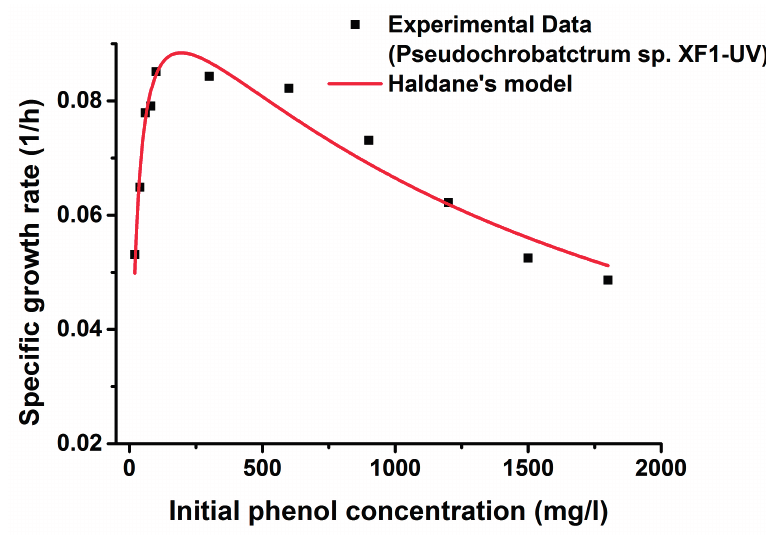
Figure 6. Experimental and predicted specific growth rates of Pseudochrobactrum sp. XF1-UV using Haldane’s